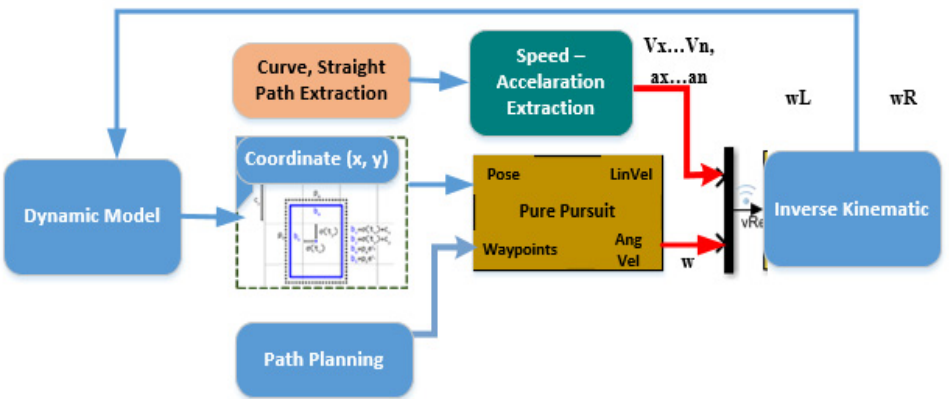
Figure 2. Mobile robot system model and speed control structure.